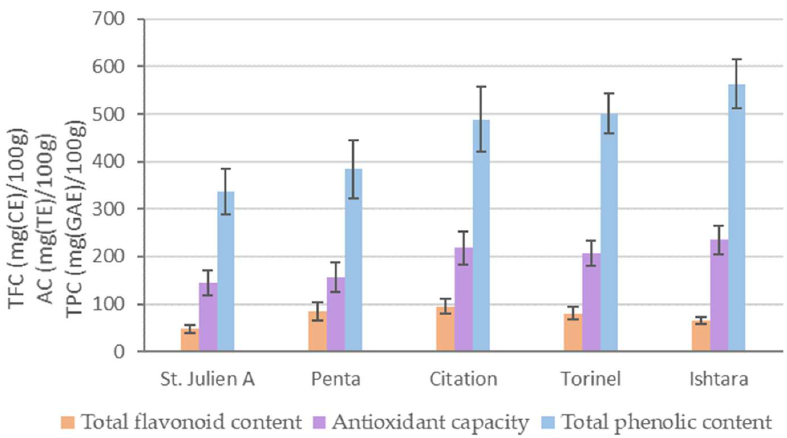
Figure 2. Average values of TFC, antioxidant capacity and TPC for analyzed plum cultivars on Citation, Ishtara, Penta, St. Julien A and Torinel rootstock. The vertical lines represent the standard deviations.